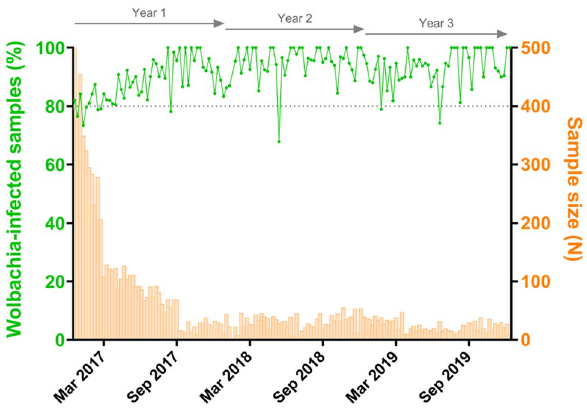
Figure 3. Post-release establishment of Wolbachia in Jurujuba. Following egg-release cessation in Jurujuba, Wolbachia- infection was monitored over the following three years, during which a self-sustained field establishment was observed. Infection indexes (%) are observed as line-connected dots (green), following the vertical left axis, whereas the sample sizes are plotted as histograms (orange), following the vertical right axis. The horizontal axis denotes time (weeks), with ticks scaled for 6-month bins. Top arrows mark yearly post-release periods. The dashed line, positioned at the 80% index mark, denotes a threshold for high-percent infection. This graph was generated in GraphPad Prism 8 (https:// www. graph pad. com).